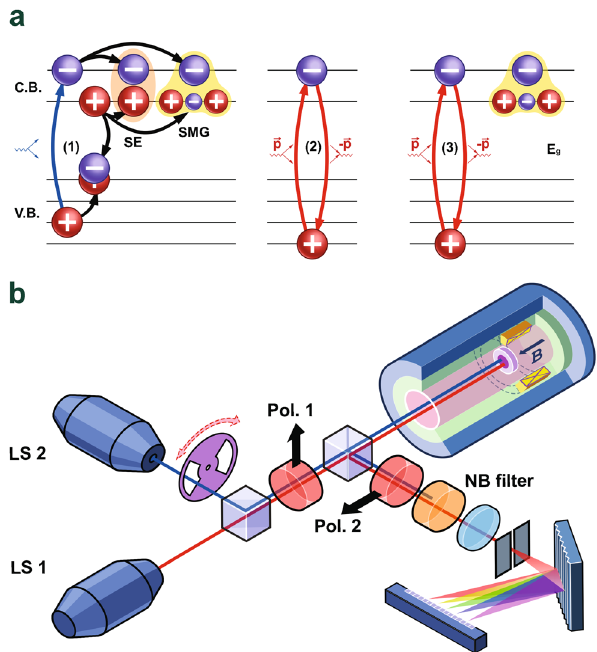
Fig. 1 Schematic diagram of the optical setup. a The optical processes utilized in the experiment. Left (1): Photoluminescence (PL) with the formation of neutral excitations. An electron from the valence band is excited into the higher spin sublevel of the zero Landau level (0LL) of the conductance band; then the resulting hole relaxes into the state of minimal energy — 0LL of heavy holes (hh); an equilibrium electron from the lower spin sublevel of 0LL of the conductance band recombines with this hole; The excited electron on higher spin sublevel and a hole left at the lower spin sublevel after the recombination form a spin exciton (SE). If during the recombination process a part of the energy is redistributed into an excitation in the lower spin state the resulting excitation is spin-magneto- graviton (SMG). Middle (2): Resonant re fl ection from the unexcited system. From 0LL of hh, an electron is excited into the higher spin sublevel of the conductance band and immediately (phase conserving process) returns back to the valence band. Right (3): Photoinduced resonant re fl ection. The process is similar to (2), but the electron is transferred in presence of a spin-zero excitation in the ground state. b The scheme of the experimental setup is shown. Pump (LS 2) and probe (LS 1) signals go through the optical scheme into the cryostat and excite the sample. The re fl ected signal is decomposed into a spectrum on a diffraction grating. For the extended description of the experimental setup and the processes, see in “ Methods ” section and Supplementary